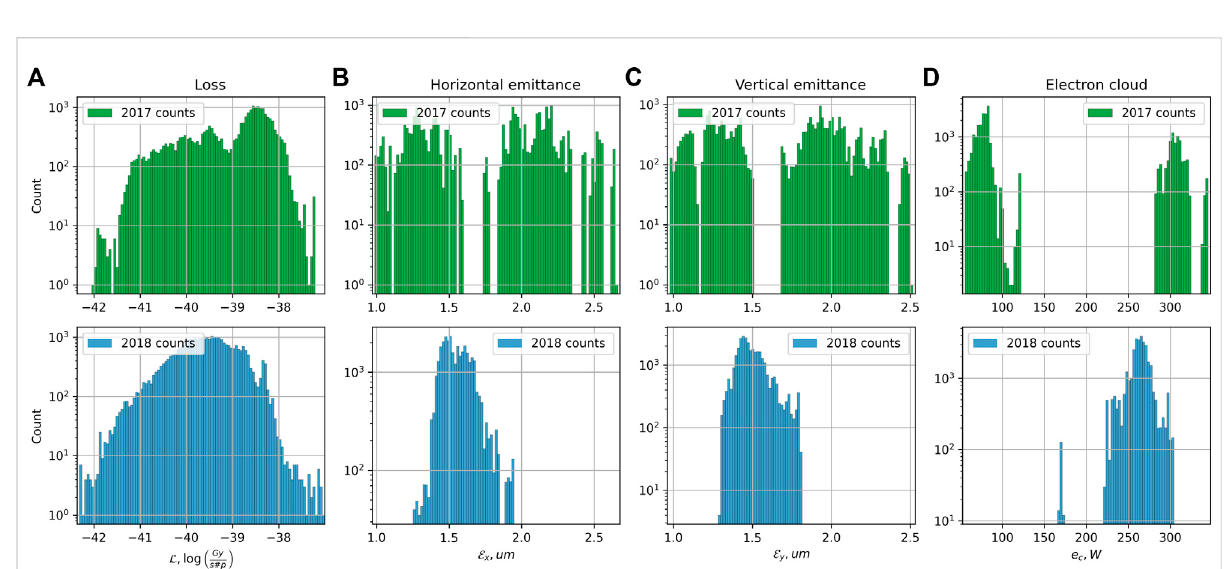
Histograms of the observationsin 2017 and 2018. (A) Logarithm of loss normalized by intensity, (B) horizontal emittance, (C) vertical emittance, (D) heatload induced by electron cloud. Almost all the variables demonstrate different ranges of values for both years, e.g. see the sum of the